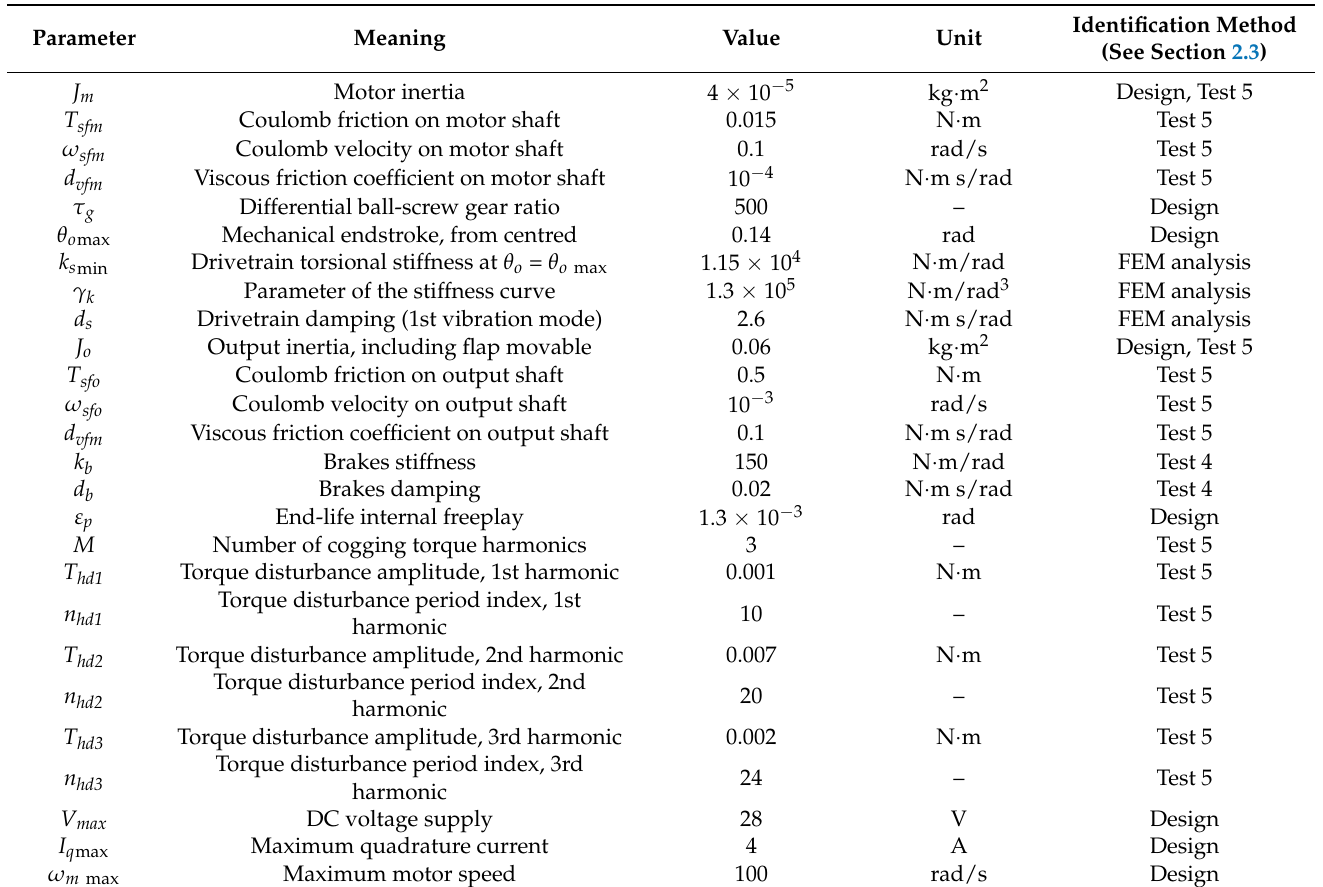
The closed-loop control of the RACER flap EMAs is schematically represented in Figure 7. The position-tracking architecture integrates the conventional three nested loops on motor currents, motor speed, and output position [8,9] with a deformation feedback loop (“Stiffness Enhancement System, SES” block in Figure 7) and a model-based correction of voltage commands, aiming to decouple the currents dynamics from the motor motion (“electro-mechanical decoupler” block in Figure 7).